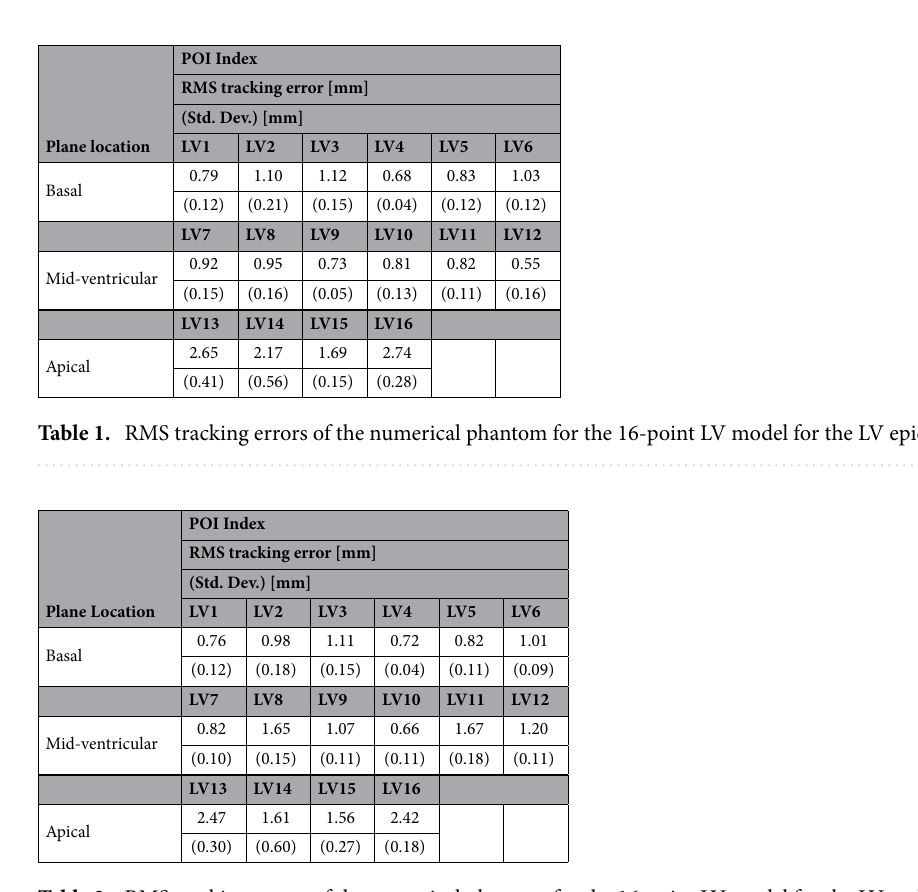
Table 2. RMS tracking errors of the numerical phantom for the 16-point LV model for the LV